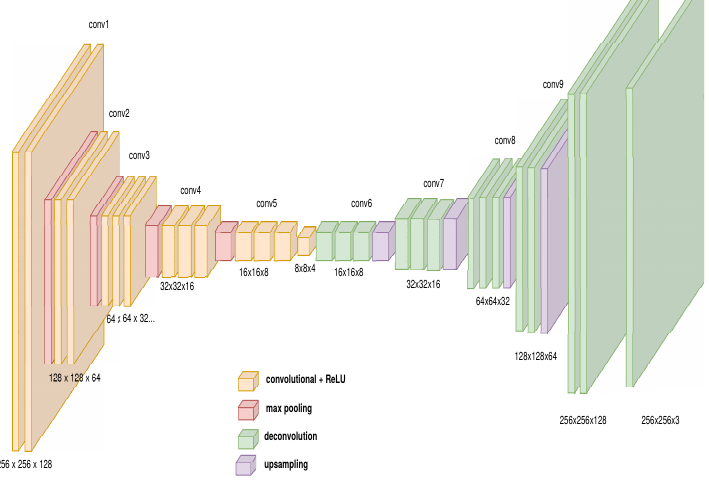
Figure 9. Autoencoder model’s features for GAN’s